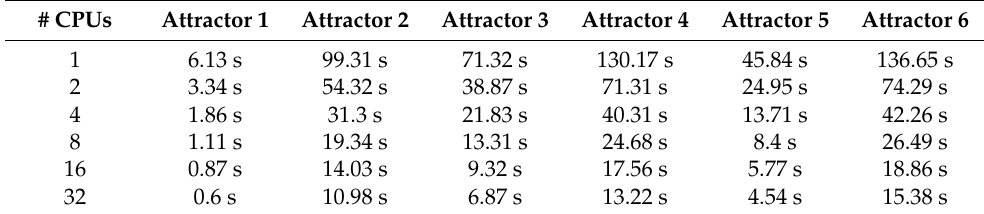
Table 2. Scalability of strong basin computation. The strong basins are computed on attractors of myeloid model